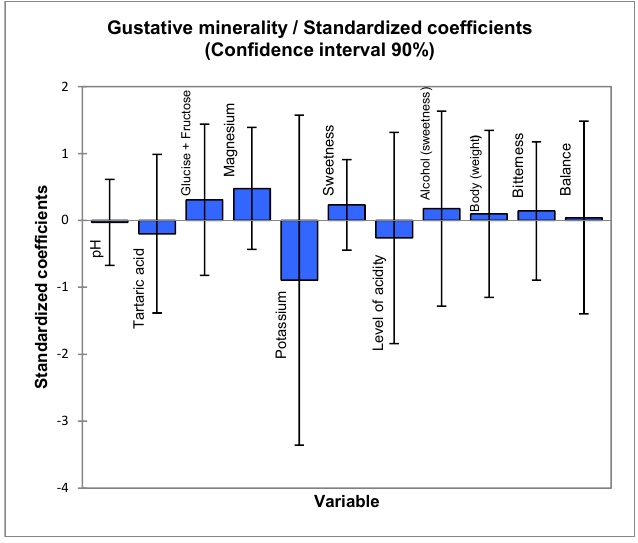
Figure 6. Standardized coefficients of regression for the predictive model of the gustatory “minerality” descriptor based on the chemical and sensory profile from the eleven white wines of the study.